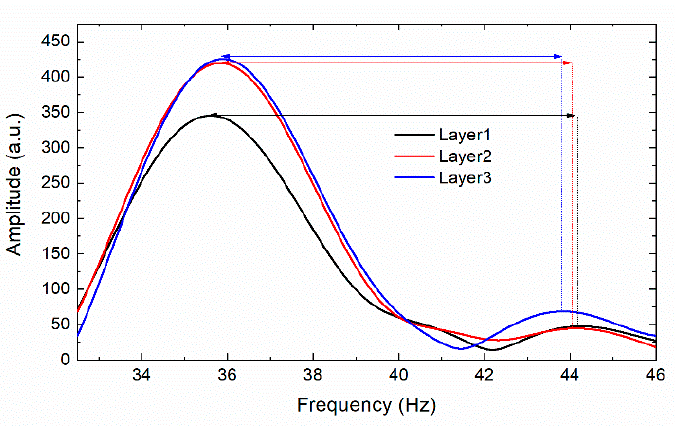
Figure 4. The spectrum diagram obtained by the CZT algorithm in evaluating concrete